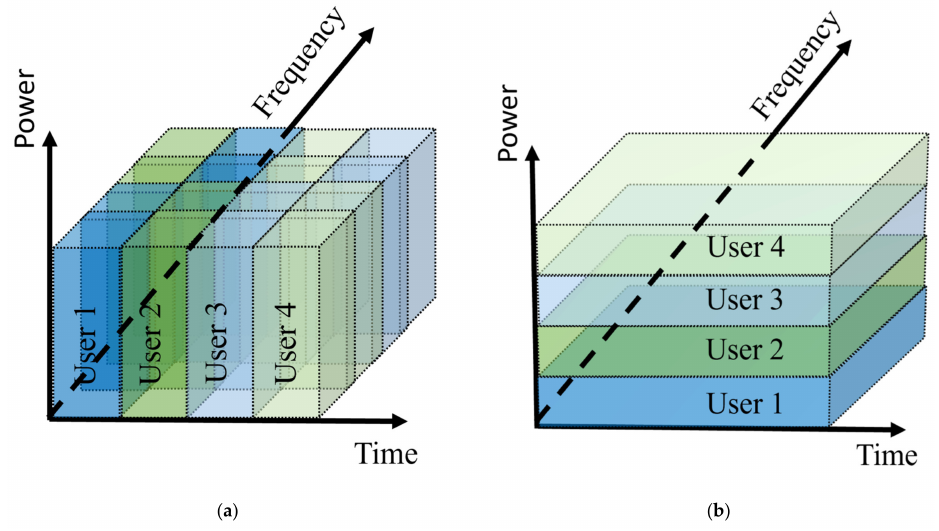
Figure 7. Spectrum sharing for ( a ) OFDMA; ( b ) NOMA.